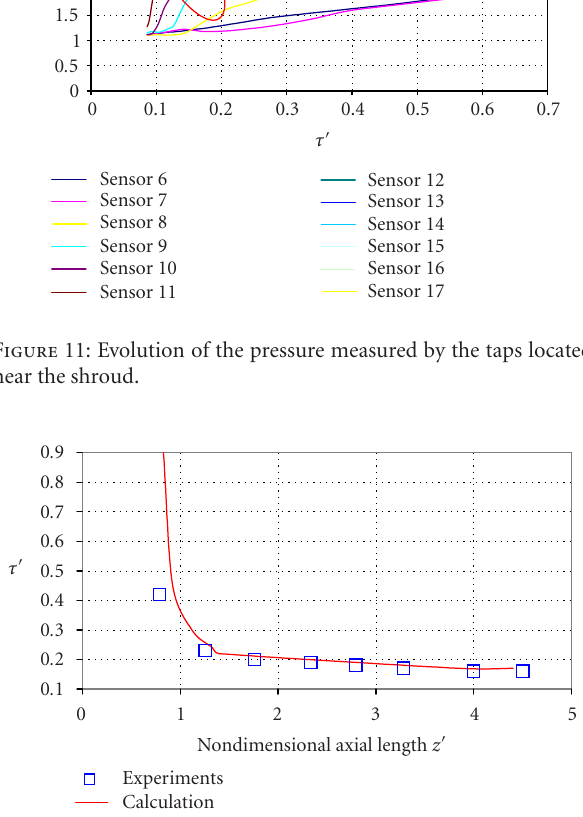
Figure 10: Influence of the maximum slope of the barotropic law on the result at nominal flow rate.